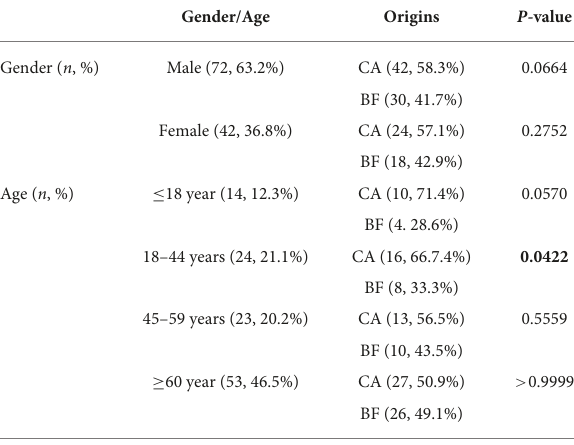
TABLE 1 Basic information of Staphylococcus epidermidis strains isolated from patients. Gender/Age Origins